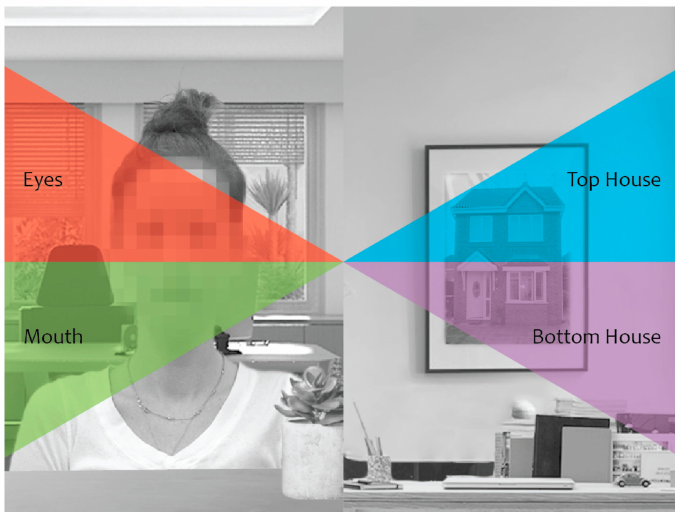
Figure 5. Regions of interest (ROI). ROIs were defined by a radial window that included the area of interest; red = eyes, green = mouth, blue = top house, and purple = bottom